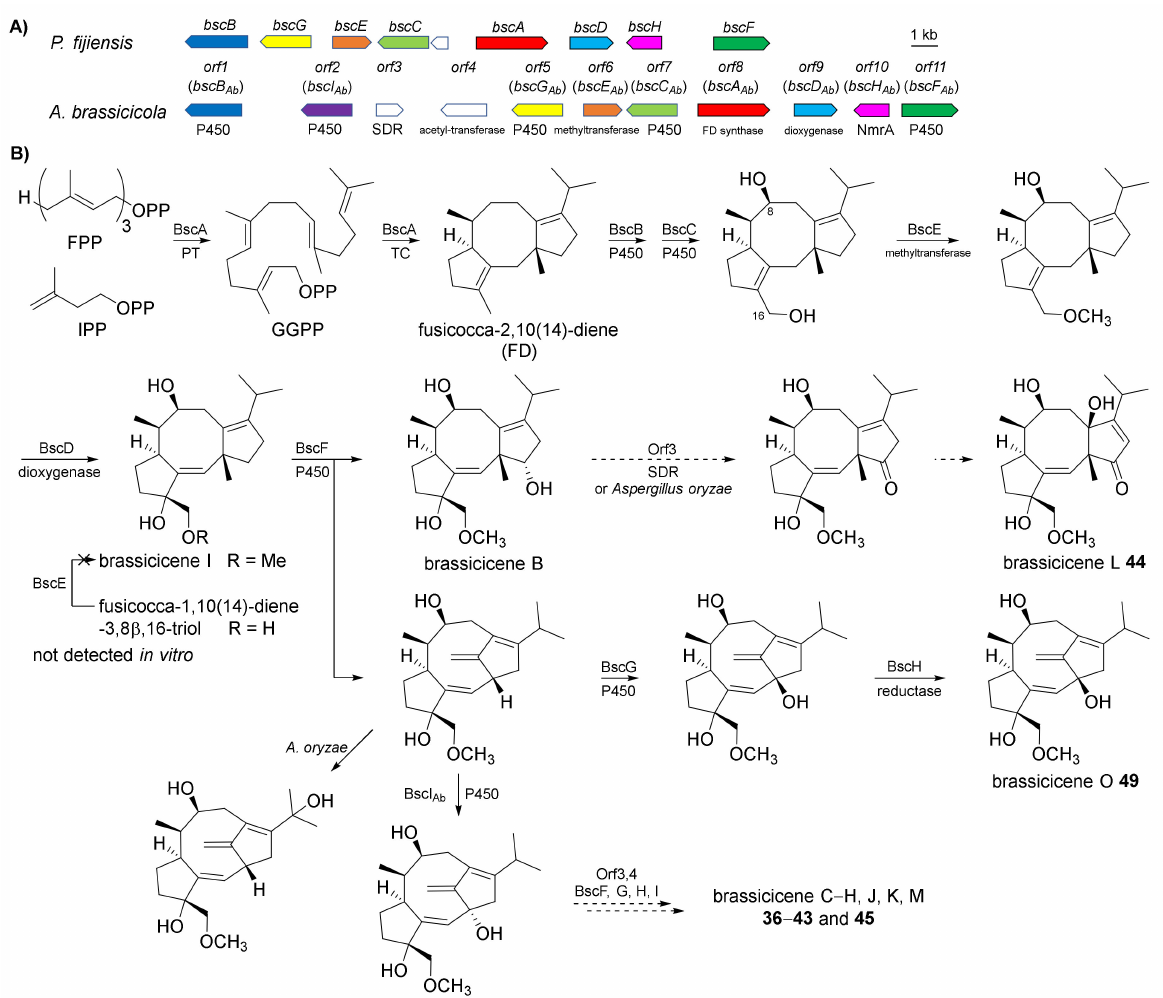
posed biosynthetic pathway for brassicicenes (dashed arrows are those deduced from expected protein function)